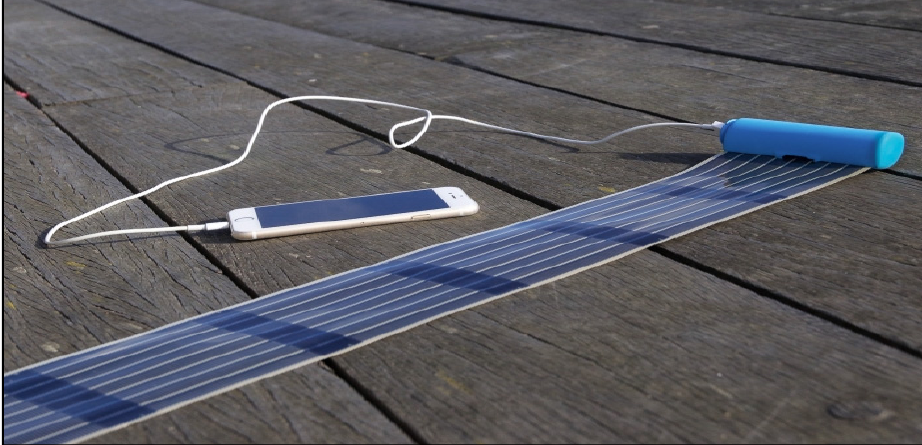
Figure 36. Ultra-thin layers and flexible organic photovoltaic panel for a phone-charging device. Much more work must be achieved before OSCs can be extensively commercialized.